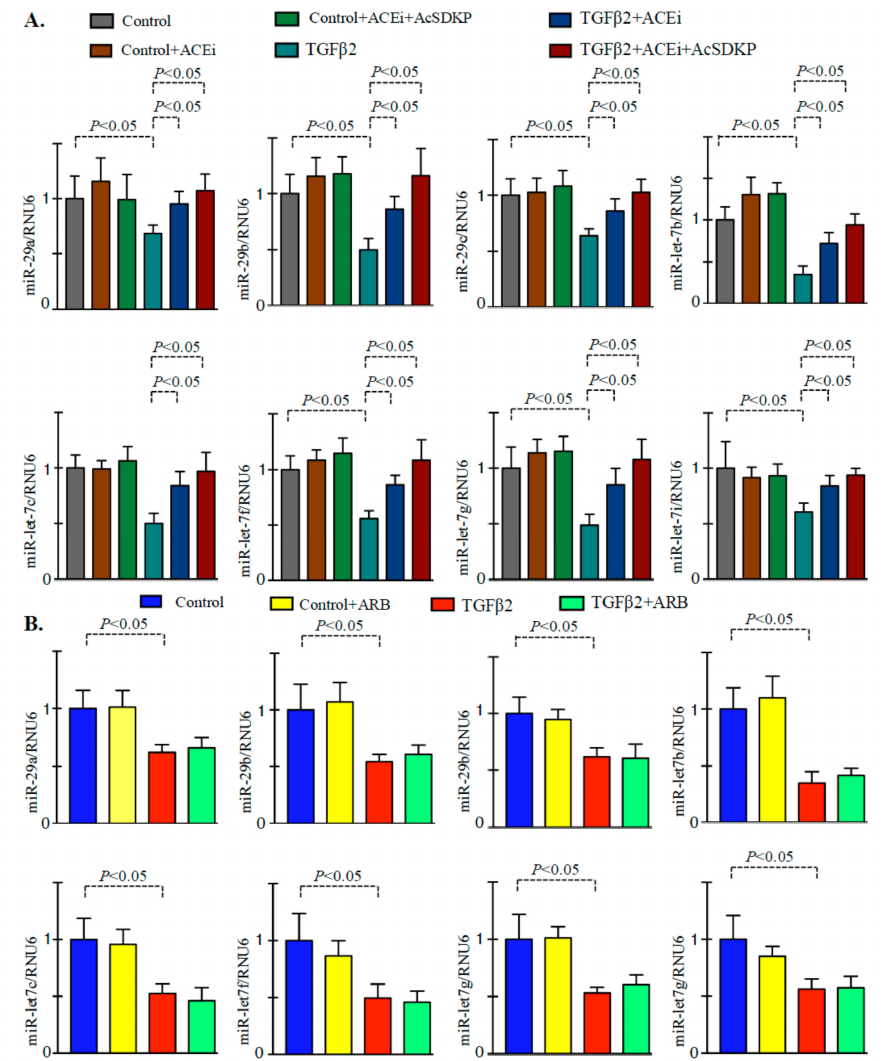
Figure 4. ACEi and combination treatment restore the downregulated level of miR-29 and miR-let-7 family members in the TGF β 2-stimulated HMVECs. ( A ) qPCR analysis of miR-29 and miR-let-7 family members in the control, ACEi, and ACEi + AcSDKP in the presence and absence of TGF β 2 in the HMVECs. N = 4 were analyzed in each group. Hs_RNU6 was used as internal control to normalize the expression data. ( B ) qPCR analysis of miR-29 and miR-let-7 family members in the control and ARB stimulation in the presence and absence of TGF β 2. N = 4 were analyzed in each group. Hs_RNU6 was used as internal control to normalize the expression data. Data in the graph are presented as mean ± SEM. One-way Anova Tukey test was performed for calculation of statistical